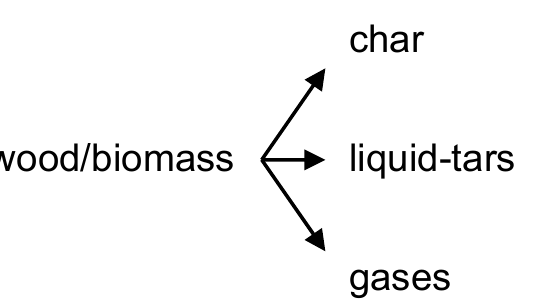
Figure 2. One-component mechanism of devolatilization by Shafizadeh and Chin [45], adapted from [44] .